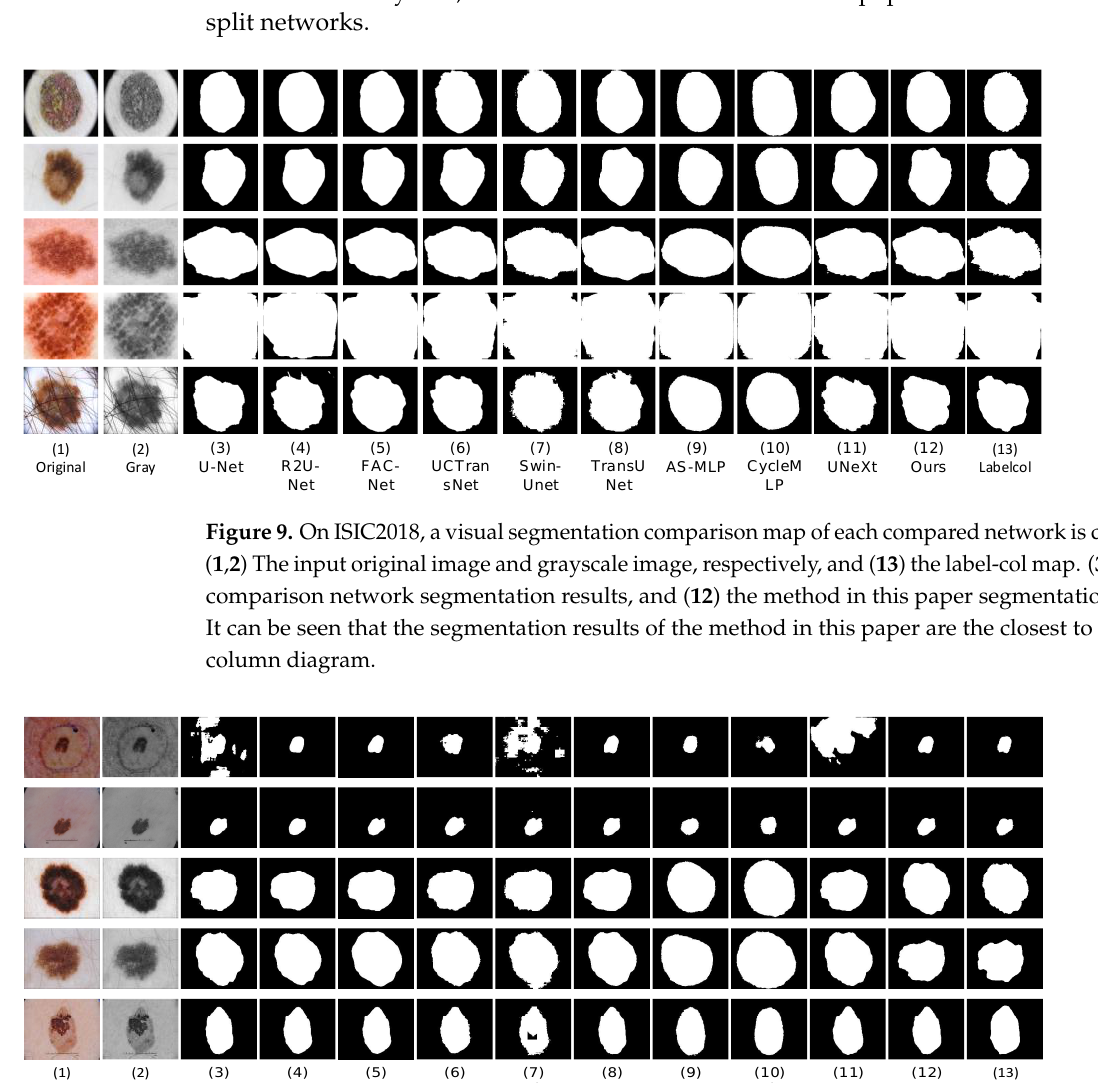
Figure 10. At ISBI2017, a visual segmentation comparison map was created for each compared network. ( 1 , 2 ) The input original image and grayscale image, and ( 13 ) the label-col map. ( 3 – 11 ) The segmentation results of the comparison networks, respectively. ( 12 ) The segmentation result of our proposed method from which we can see that the segmentation result of our proposed algorithm is closest to the label-column map.